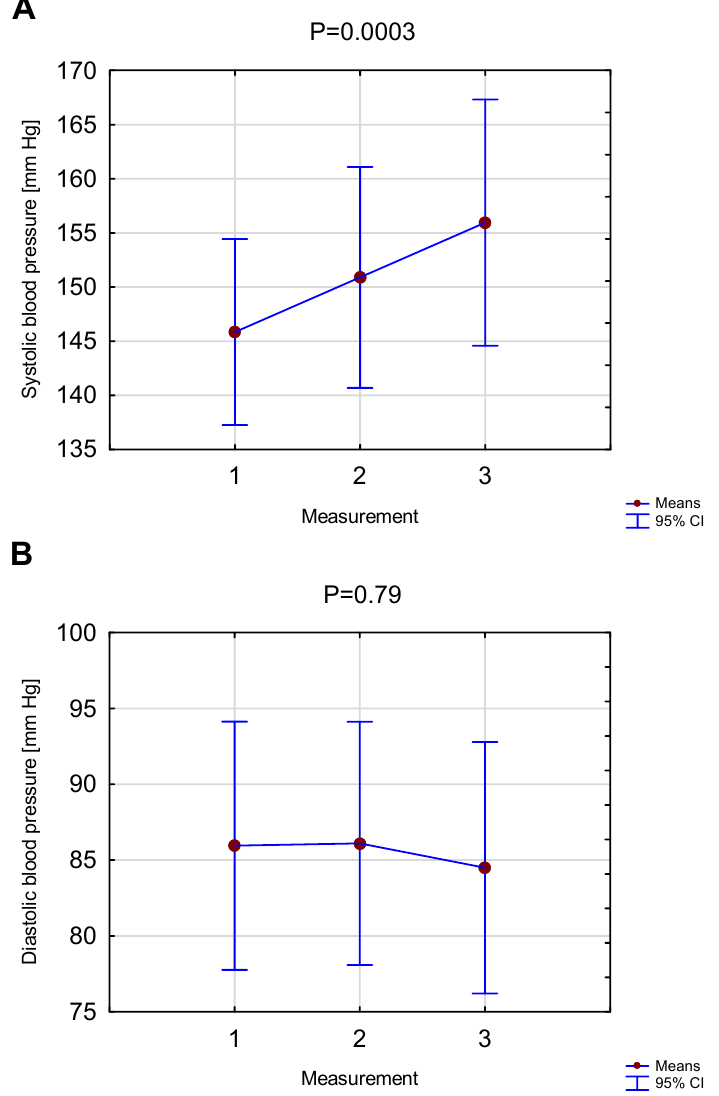
Figure 2. Systolic ( A ) and diastolic ( B ) blood pressure values in three consecutive measurements carried out during vibration hemodialysis. 1, baseline measurement before the first cycle of vibrations; 2, measurement after the second cycle of vibrations; 3, final measurement after the fifth cycle of